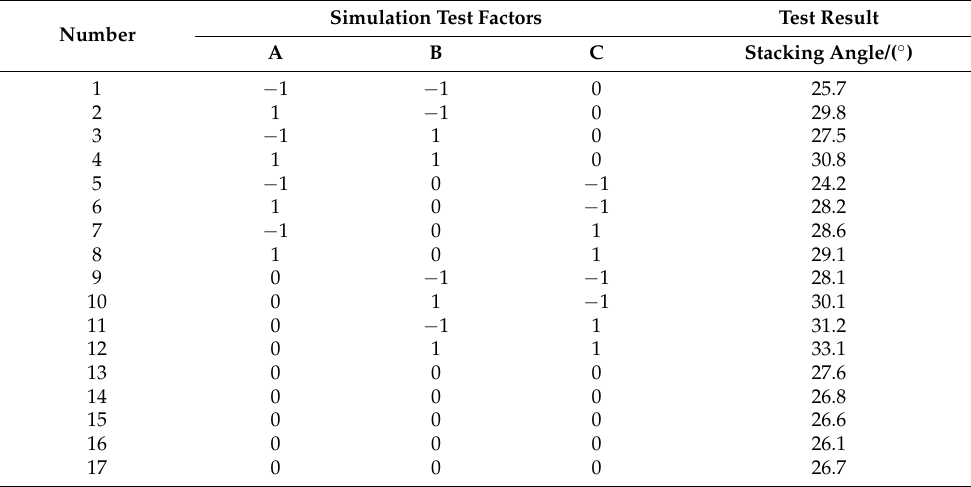
Table 6. Box–Behnken test design scheme and